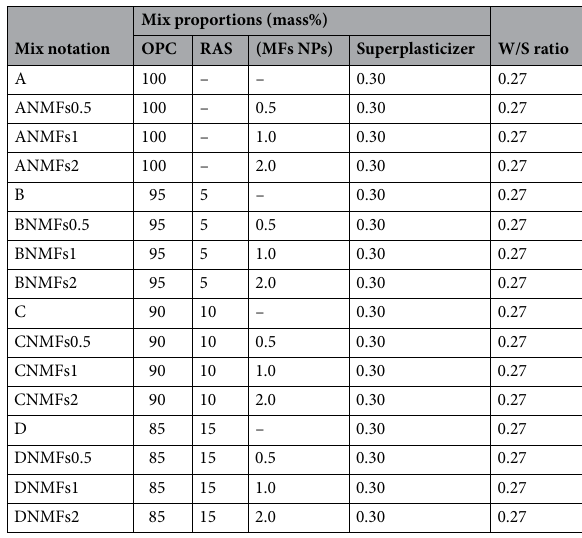
Table 4. The percentage composition of the different mixes and their